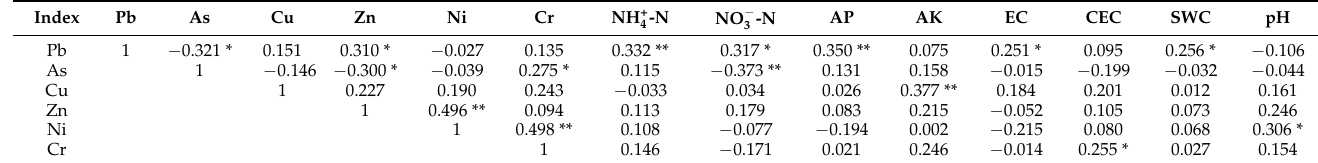
Table 3. Correlation analysis between soil heavy metals and soil physical and chemical properties.